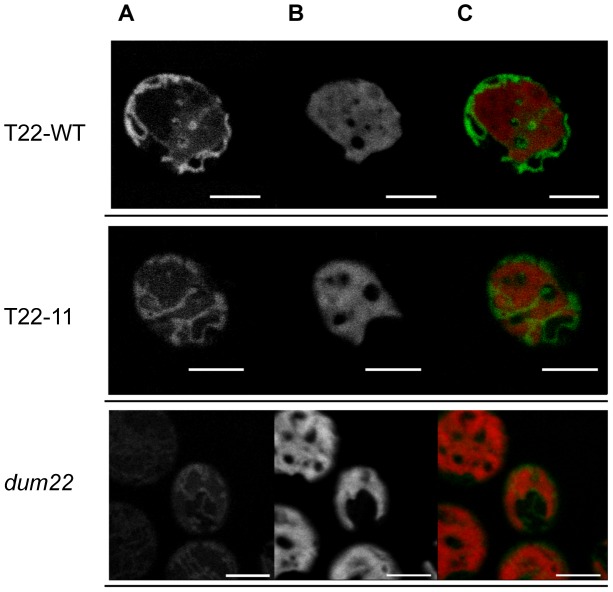
Confocal microscopy of mitochondria from T22-WT, T22-11, and dum22 stained with MitoTracker dyes.Visualization in T22-WT, T22-11 and dum22 strains (A) of mitochondria by MitoTracker dye, (B) of chloroplast by chlorophyll autofluorescence and (C) of the overlapping images in Chlamydomonas cells. The white line corresponds to 5 µm.